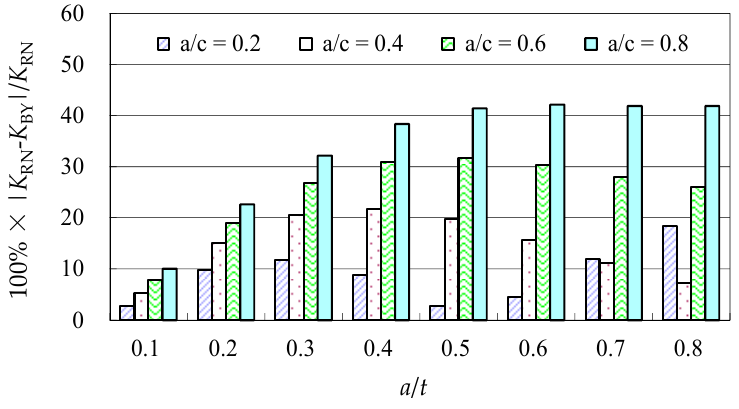
Figure 6. The Baik-Yamada formula vs. the Raju-Newman solution at point B ( c / W = 0.2).